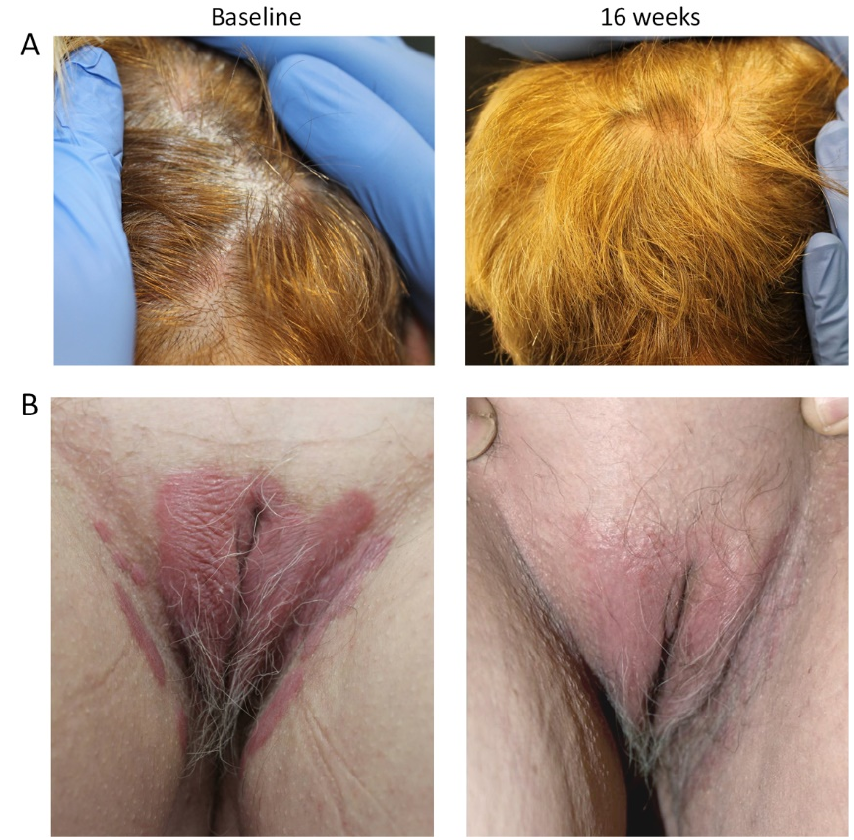
Figure 2. Representative images of outcome in Case #1; female patient aged 63 years, with severe scalp ( A ) and genital ( B ) psoriasis. After 16 weeks of tildrakizumab treatment, PASI decreased to 0.6, sPGA-G to 1, NAPSI to 0 and PSSI to 0.